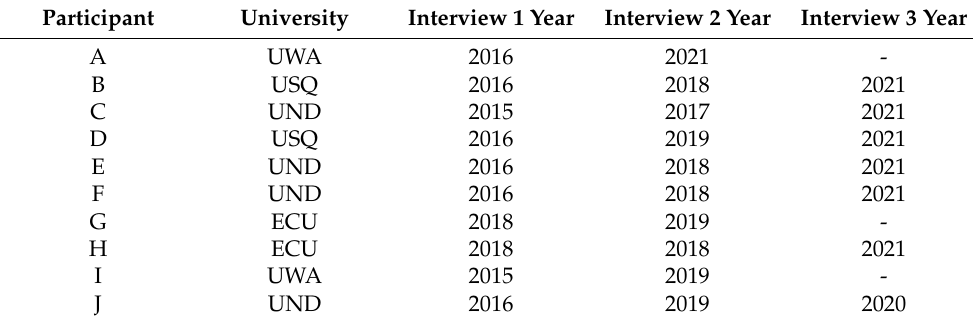
Table 1. Participant information and interview